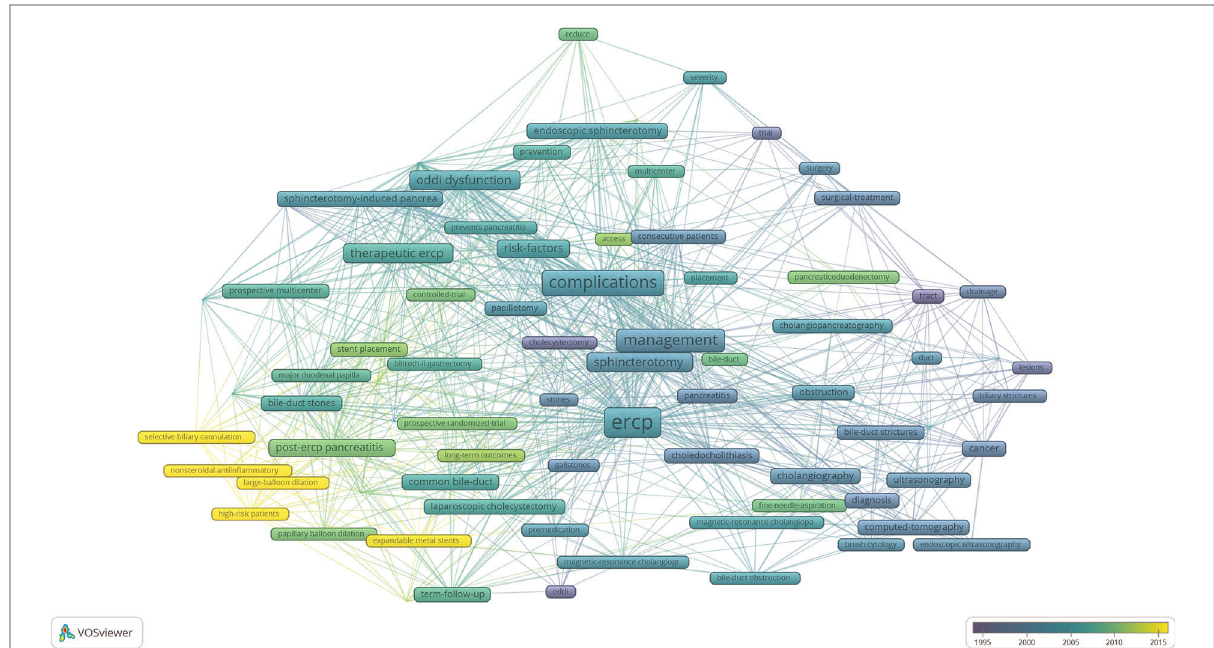
FIGURE 6 Overlay visualization map showing trends of keyword frequency over time. Colors were assigned according to the average year in which keywords appeared in